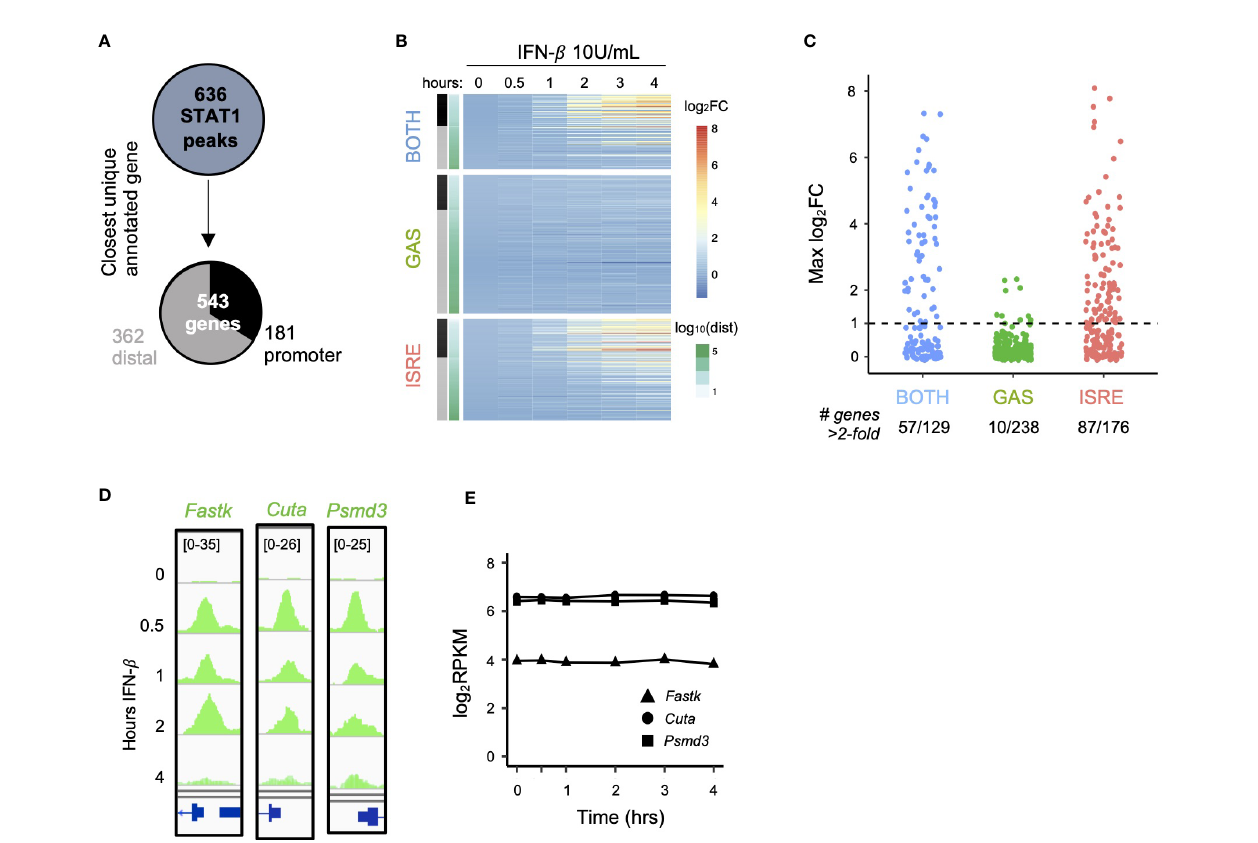
FIGURE 3 | GAF does not induce expression of nearby genes. (A) Schematic for linking peaks to genes. Promoter de fi ned as -1000 to +100 bp from TSS. (B) Heat map of log2 fold change of genes linked to STAT1 peaks, clustered by STAT1 peak motifs. Genes are ordered by distance to STAT1 peak. (C) Dot plot of genes in each category showing number of genes above 2-fold induction threshold. (D) Genome browser tracks of representative STAT1 peaks with GAS motifs at promoters of three genes. (E) Gene expression response to IFN- b (10 U/ml) for same genes as in (D)